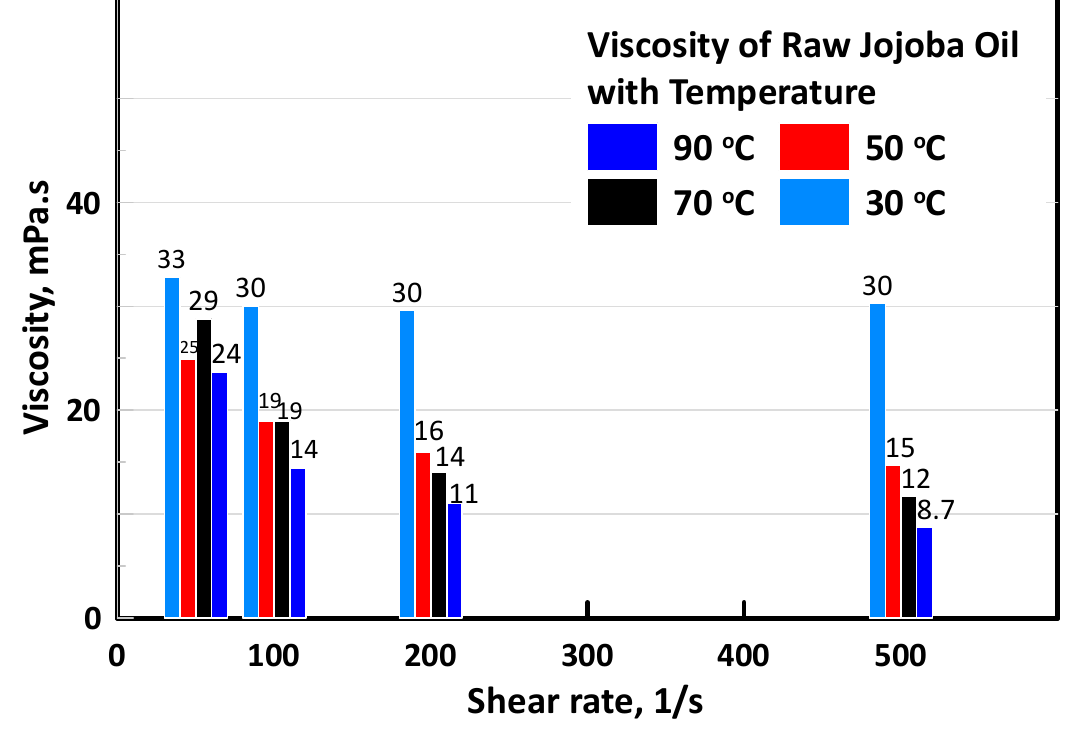
Figure 2. Viscosities of raw Jojoba oil at different